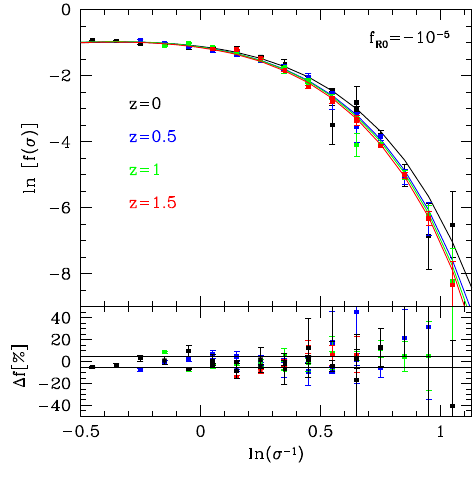
Fig. 10 Mass function for f R0 = − 10 − 5 at redshifts z = 0 − 1 . 5. The solid lines are theoretical predictions, squares with errorbars are from simulations. The lower panel shows the relative difference. The black solid lines show ± 5% differences. Image reproduced with permission from Achitouv et al. (2016), copyright by